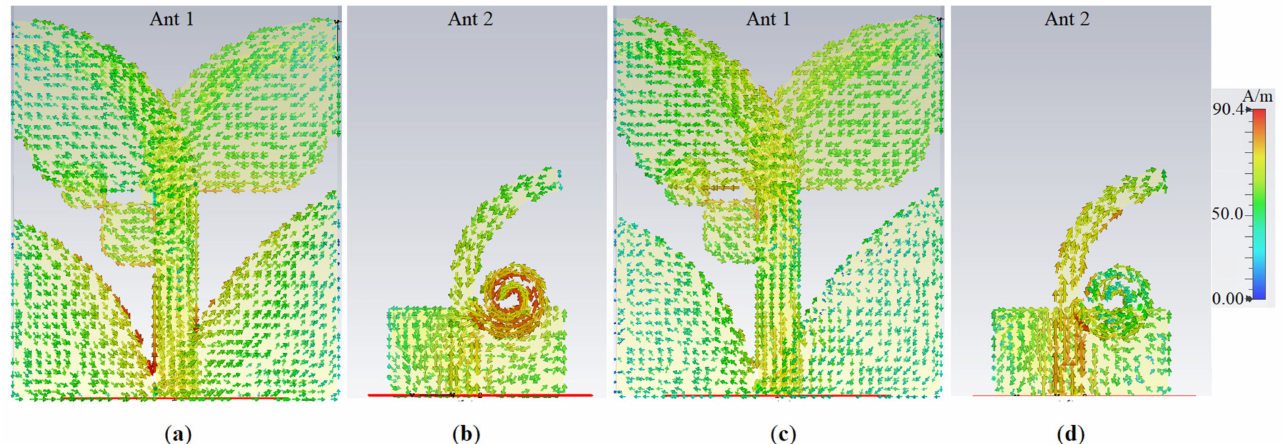
Figure 2. The surface current density for Ant 1 and Ant 2: ( a ) and ( b ) at 3.8 GHz; ( c ) and ( d ) at 5.2 GHz (red color is maximum and blue is the minimum).